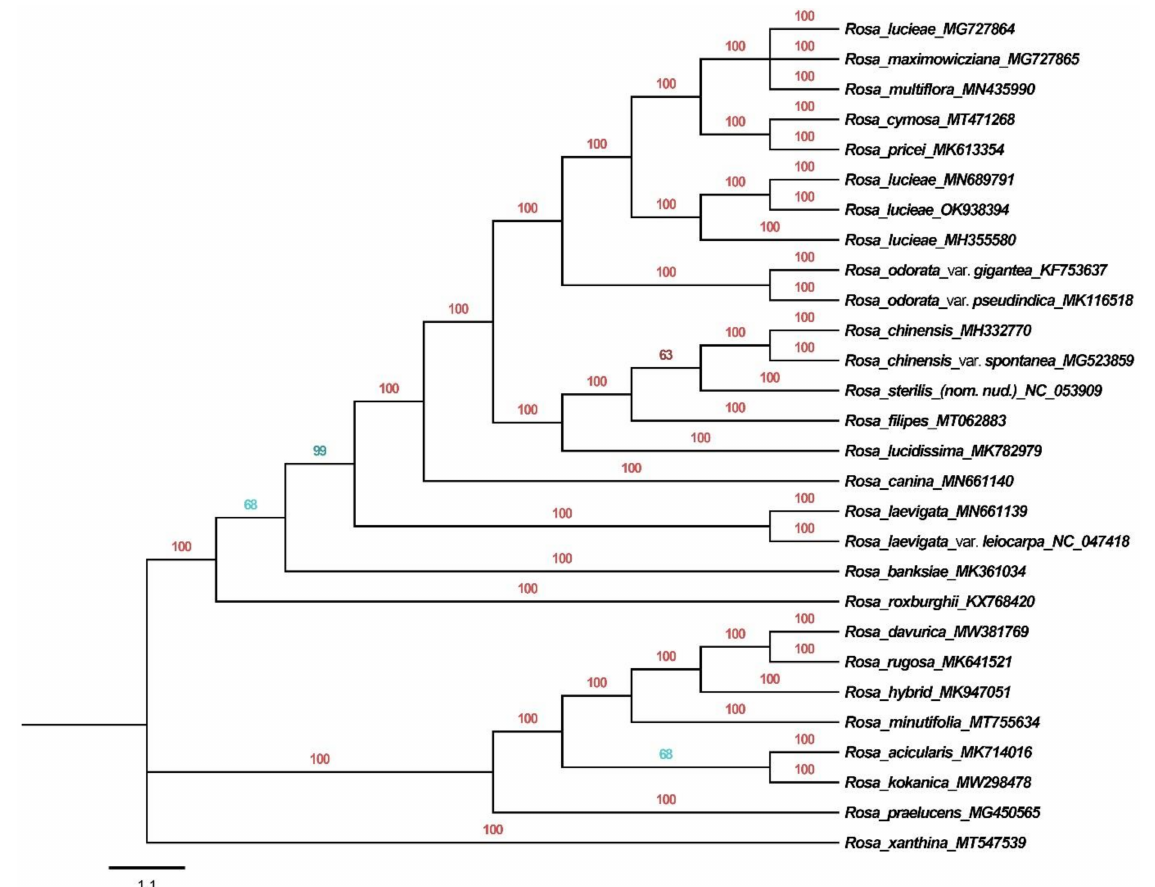
Figure A2. Molecular phylogenetic BI tree topology constructed by CDS with 28